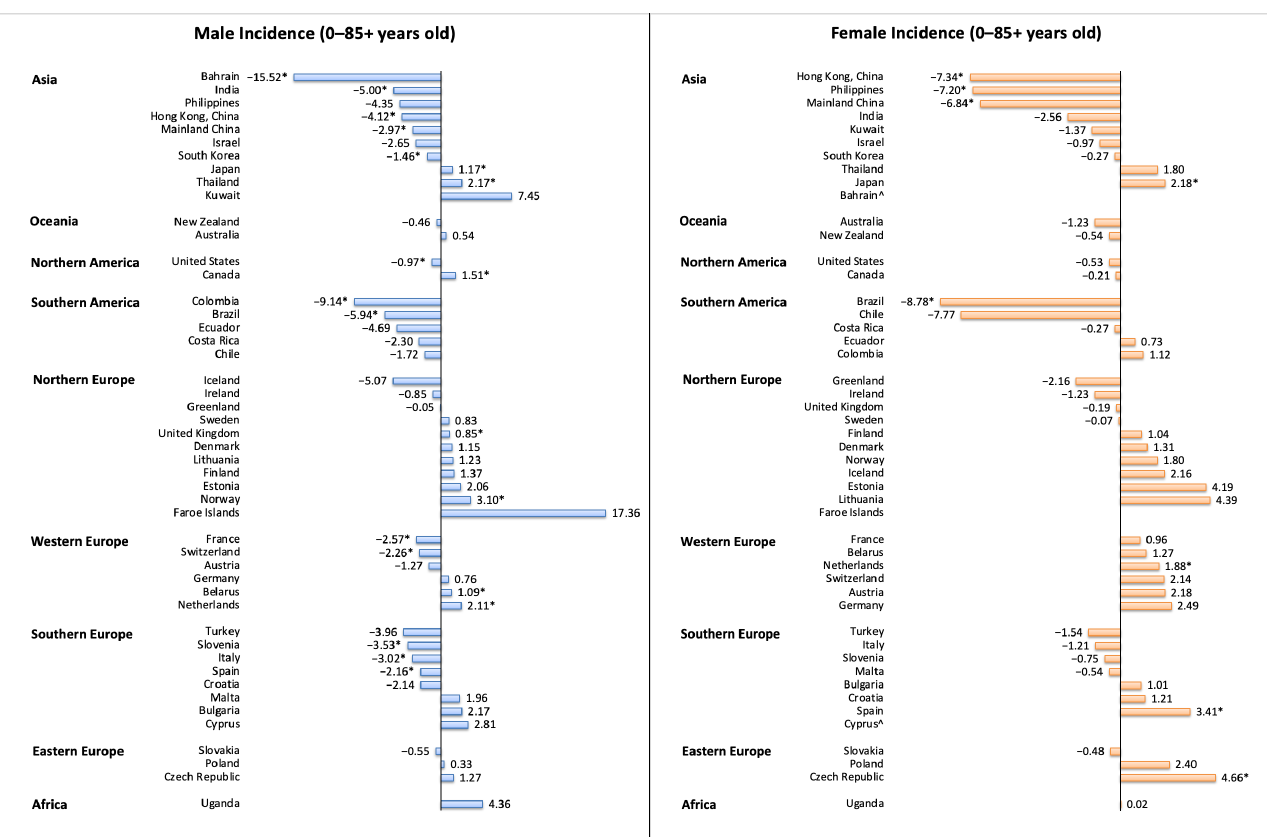
Figure 4. The AAPC of the incidence of esophageal cancer in individuals aged 0-85+ years